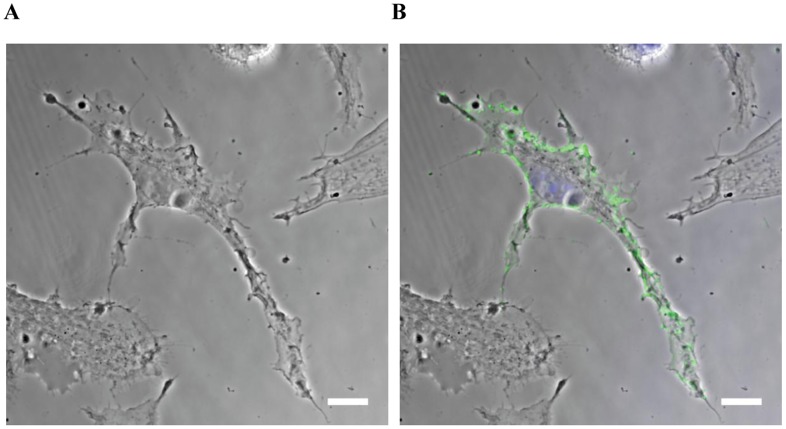
Morphology of ESDC and MHC-II expression was observed by confocal microscopy.Stimulated ESDCs were imaged using a Confocal Zeiss LSM510; (A), phase contrast, (B) cell stimulated with TNFα and stained with anti-MHC Class II FITC conjugated antibody. Scale bar 10 µm.